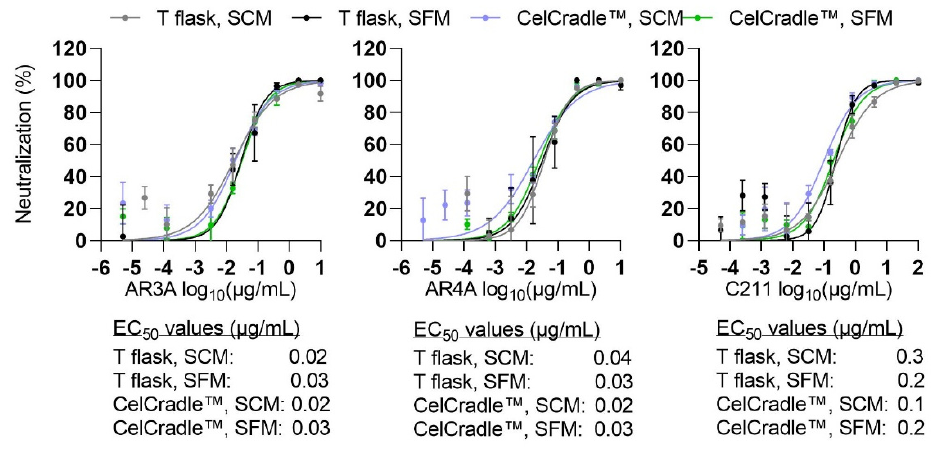
Figure 6. Neutralization sensitivity of HCV produced in the CelCradle™ and in monolayer cultures under SC and SF conditions is similar. Sensitivity to neutralization by human monoclonal antibodies AR3A ( left ) and AR4A ( middle ) and human polyclonal antibody preparation C211 ( right ) was compared for HCV produced under SC conditions (CC-DMEx1-SCM, Figure 1) or SF conditions (CC- DMEx1-SFM ₁ , Figure 2) in the CelCradle™ or in T flasks in in vitro neutralization assays. Datapoints are means of triplicates with SEM. Variable slope sigmoidal dose-response curves were fitted to determine EC 50 values as described in Materials and Methods; EC 50 values are indicated in the figure.